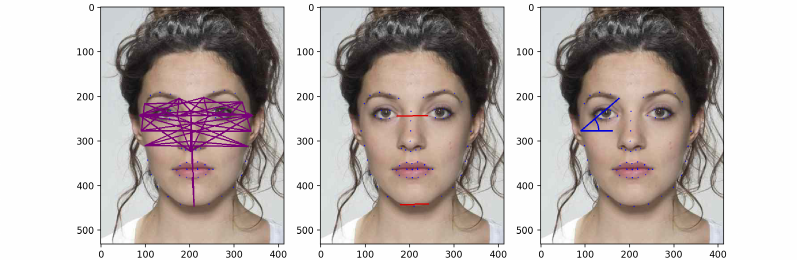
Figure 5. ( Left ) Forty-seven distances used in Φ R . ( Middle ) Two benchmark distances used in Φ R . ( Right ) Angle calculation as in Φ A